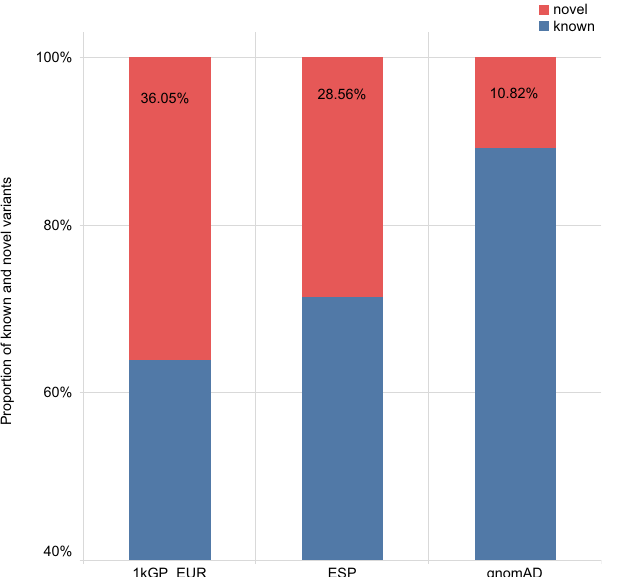
Figure 5. Ratio of known and novel variants in the Serbian population sample. Per reference database: 1kGP_ EUR, gnomAD and NHLBI ESP.